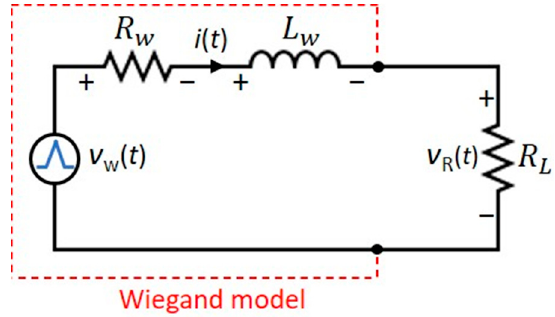
Figure 4. Equivalent electrical model of the Wiegand